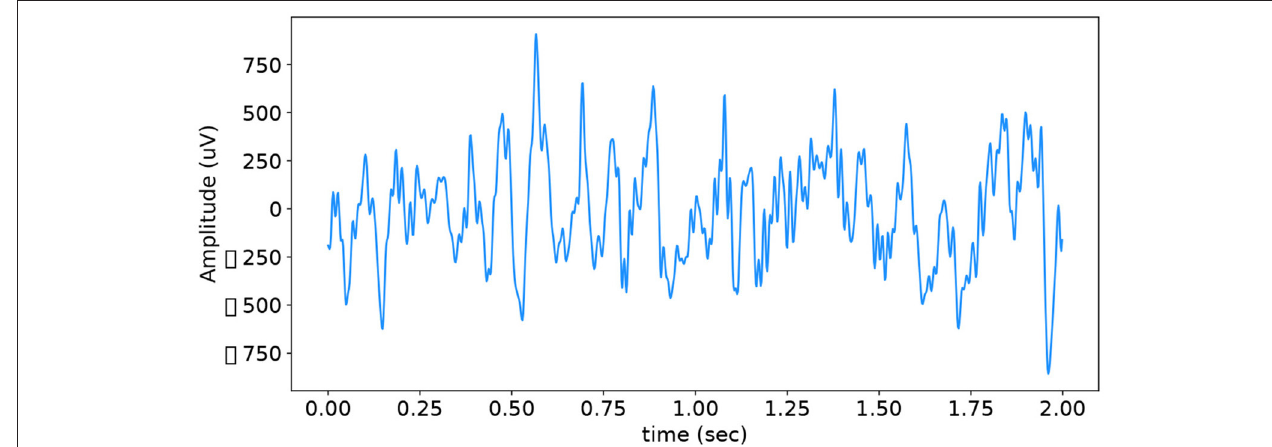
FIGURE 1 | Typical example of clean EEG.